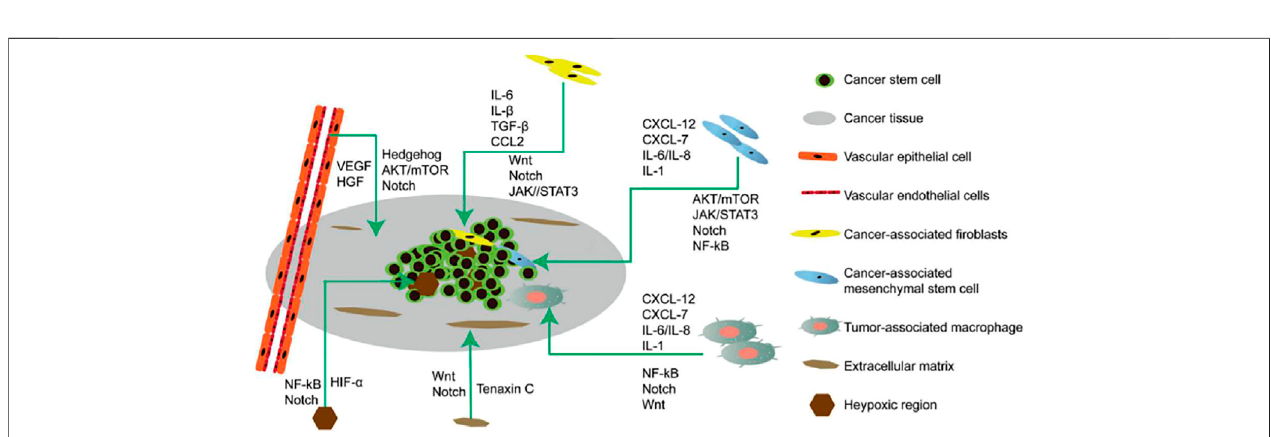
FIGURE 2 | Microenvironment of cancer stem cells (CSCs) illustrating their proliferation, self-renewal, differentiation, metastasis, and tumorigenesis. The CSC microenvironment is mainly composed of vascular niches, hypoxia, tumor-associated macrophages, cancer-associated fi broblasts, cancer-associated mesenchymal stem cells, and an extracellularmatrix. Thesecells, in response tohypoxic stressand matrices,induce growth factors and cytokines (suchas IL-6and VEGF) toregulate CSC growth Via Wnt, Notch, and other signaling pathways.